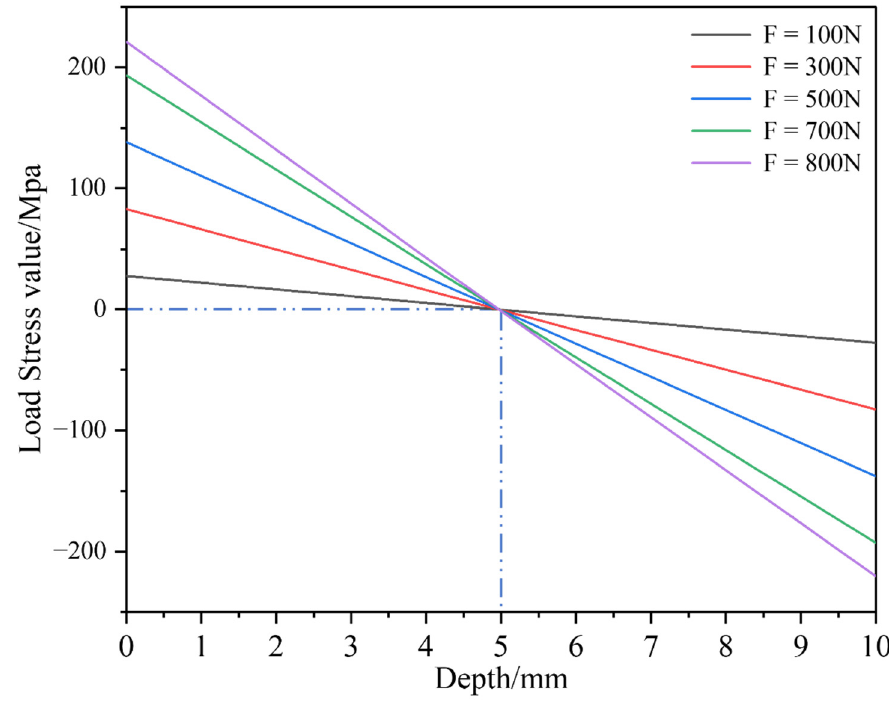
Figure 11. Distribution curves of cantilever beam stress with depth under different loading forces.